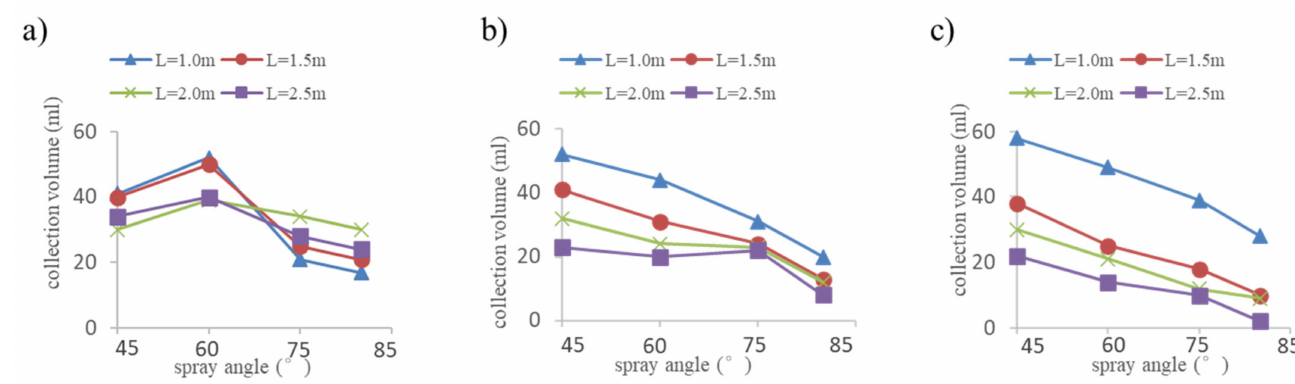
Figure 8. Influence of the three control parameters on the collection volume. ( a ) Influence of the spray angle and spray distance on the collection volume (N = 2000 r/min). ( b ) Influence of the spray angle and spray distance on the collection volume (N = 2400 r/min). ( c ) Influence of the spray angle and spray distance on the collection volume (N = 2800